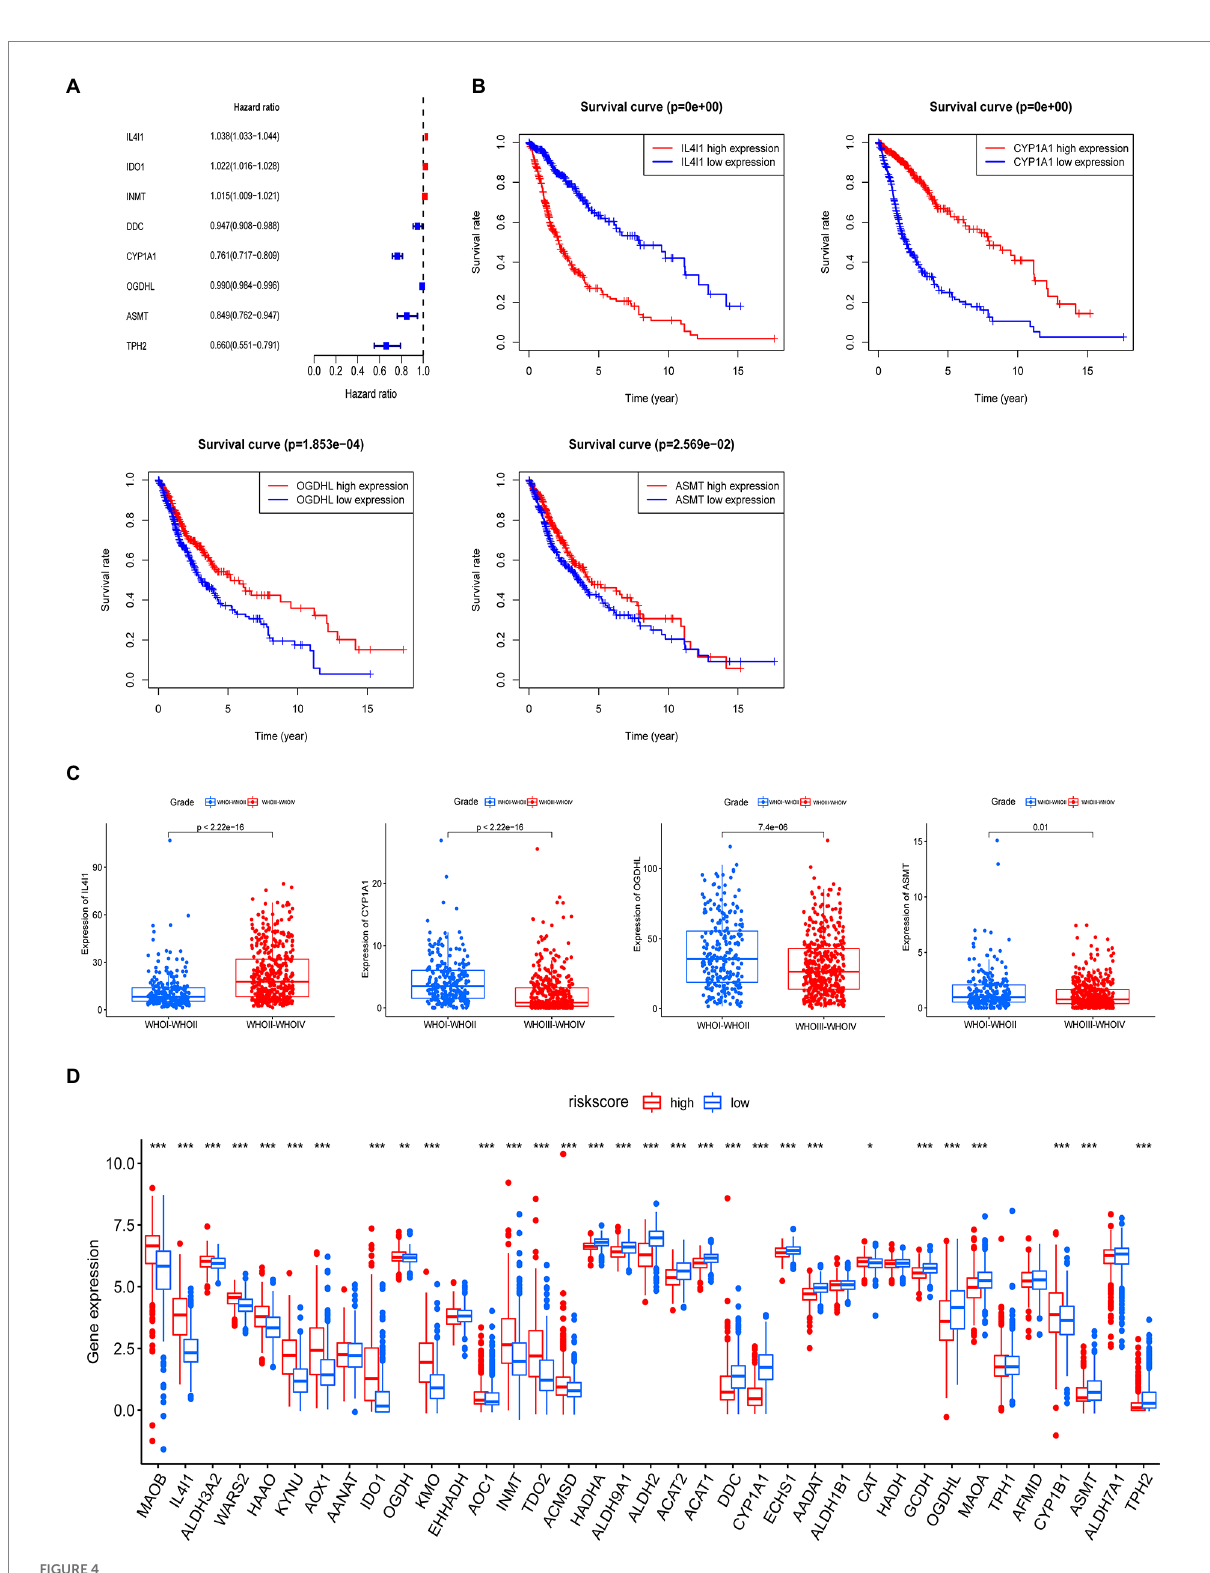
FIGURE 4 A prognostic model for predicting patients with glioma based on tryptophan metabolic gene expression. (A) Univariate Cox regression analysis demonstrated eight tryptophan metabolic genes were related to the prognosis of glioma. (B) Multivariate Cox regression analysis demonstrated four tryptophan metabolism genes were most relevant to the prognosis of glioma; a Kaplan–Meier curve for the overall survival of these genes ( IL4I1 , CYPIA1 , OGDHL , and ASMT ) is shown. (C) The relationship between IL4I1 , CYPIA1 , OGDHL , and ASMT and tumor stage. (D) The expression of 40 tryptophan metabolism genes in high and low risk groups. * p < 0.05, ** p < 0.01, *** p <